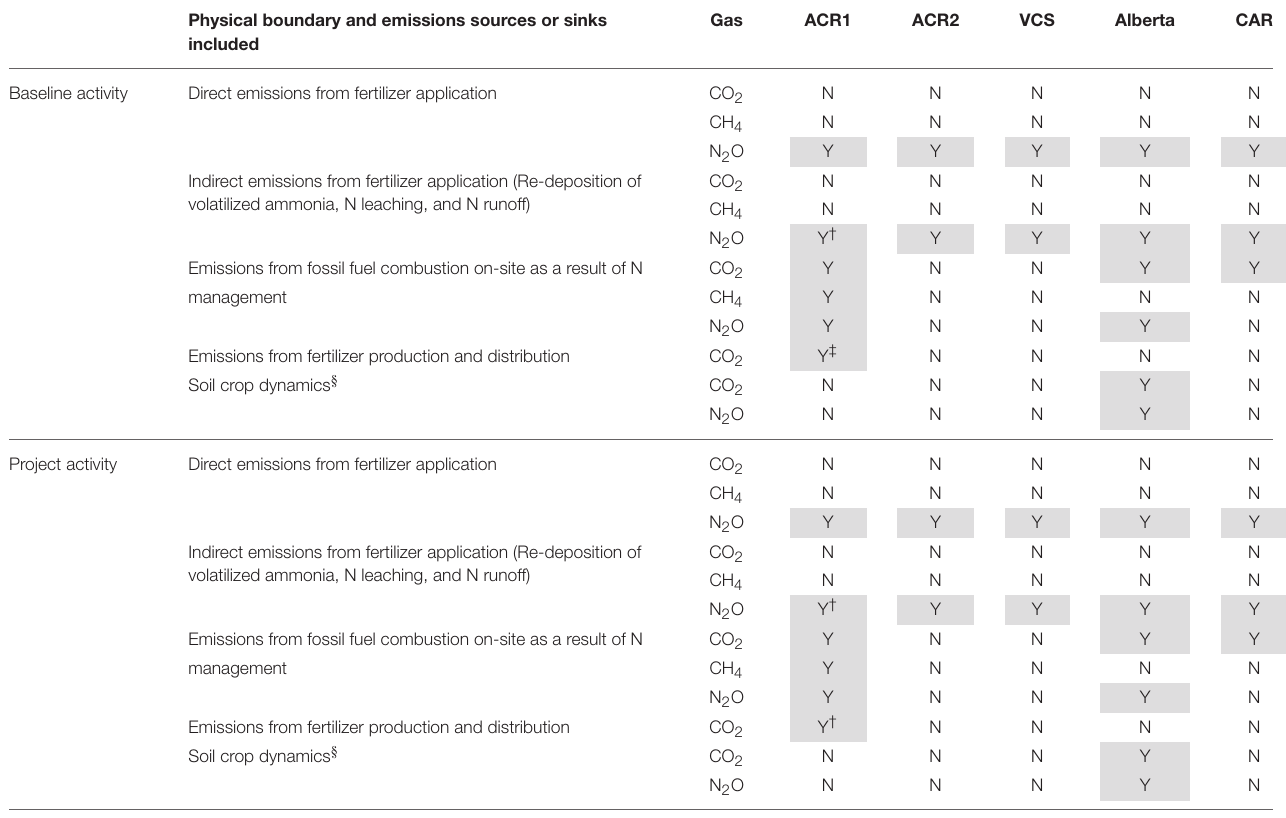
TABLE 3 | Emission sources and sinks included in quantification of baseline and project N 2 O emissions by protocol. Physical boundary and emissions sources or sinks